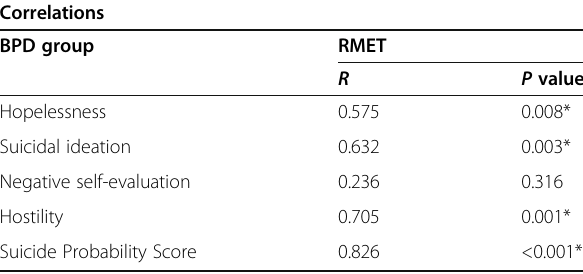
Table 4 Correlation between RMET and suicide probability in BPD group